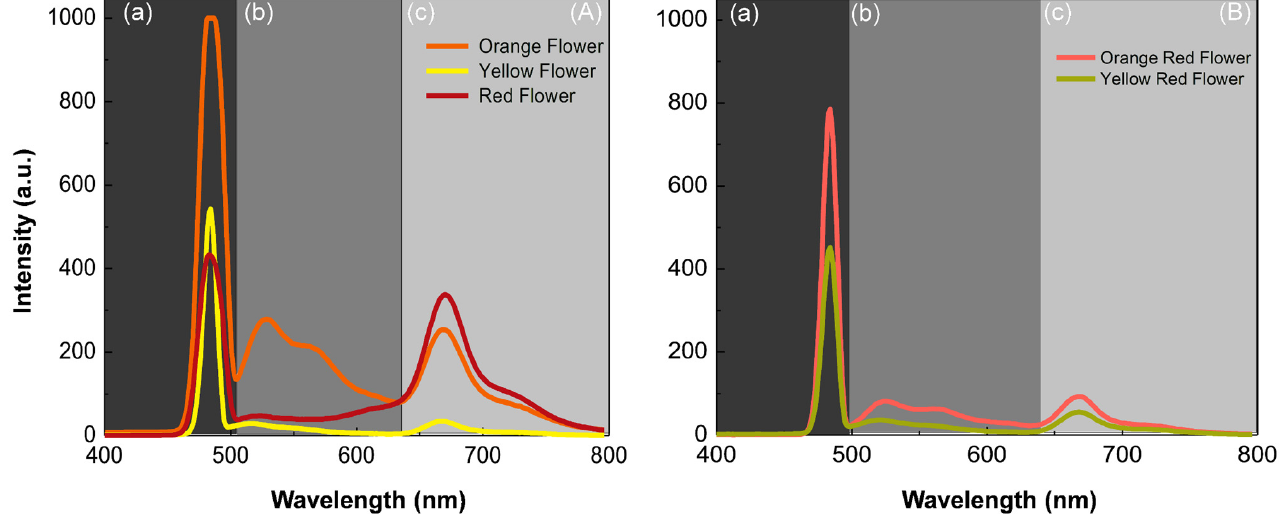
Figure 6. Fluorescence intensity (in arbitrary units, a.u.) at different wavelengths of orange, yellow and red corolla flowers ( A ), nectar-guided flowers (orange-red and yellow-red) ( B ) of Tropaeolum majus. Fluorescence intensity corresponding to fluorophores and flavonols ( A ( a ), B ( a )—black); β -carotene and anthocyanin ( A ( b ), B ( b )—dark gray); and chlorophyll ( A ( c ), B ( c )—light gray). Orange corolla flowers showed a broad fluorescence band from 475 to 800 nm (Figure 6A). We found that, between 400 and 600 nm, fluorescence was due to the presence of compounds such as hydroxycinnamic acid, flavonols, isoflavonoids, flavones, and phenolic acid, while between 600 and 800 nm, it was due to chlorophyll [54]. As most of these compounds are present in T. majus flowers, the fluorescence spectrum pattern (Figure 6) agrees with their contents [50,51]. Orange flowers of T. majus have the largest amounts of kaempferol, followed by red and yellow ones [51]. Among the flavonols in paprika samples, kaempferol had the highest fluorescence intensity at excitation, around 405 nm, whereas quercetin and myricetin had much lower intensities [55]; therefore, the fluorescence of the region (a) in Figure 6 is determined by kaempferol in orange and red flower extract samples, greater in orange than in red flowers. The spectrum in this region of